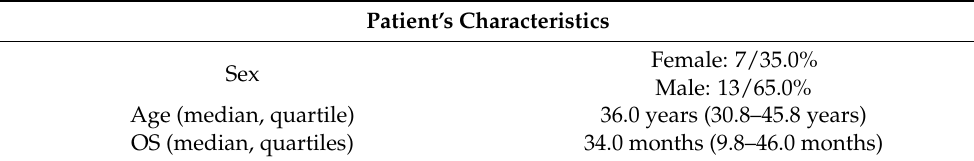
Table 2. Clinical parameters of gliomas grade 2/3 ( n = 20).